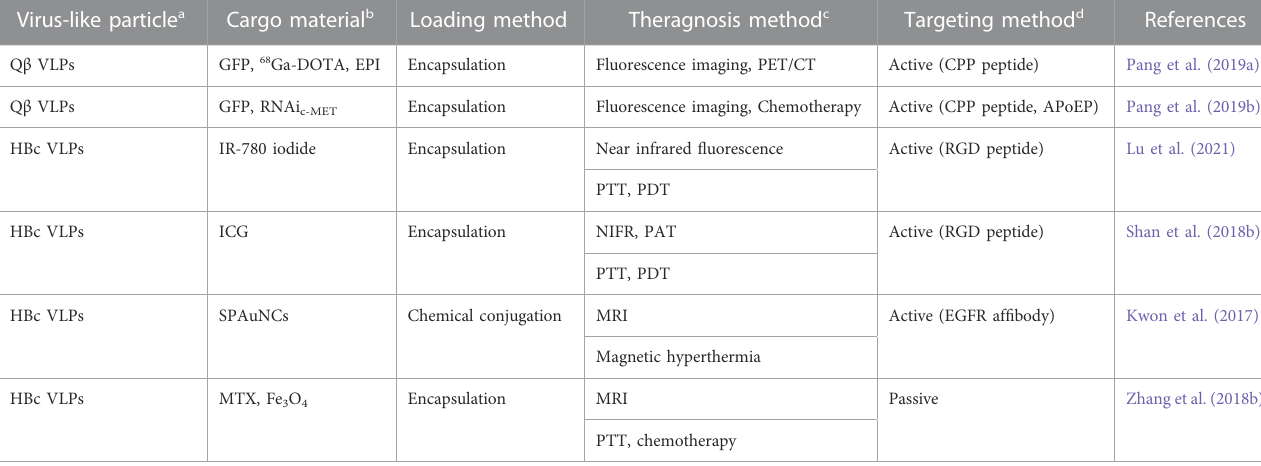
TABLE 3 Comparison of virus-like particles for theragnosis. Virus-like particle